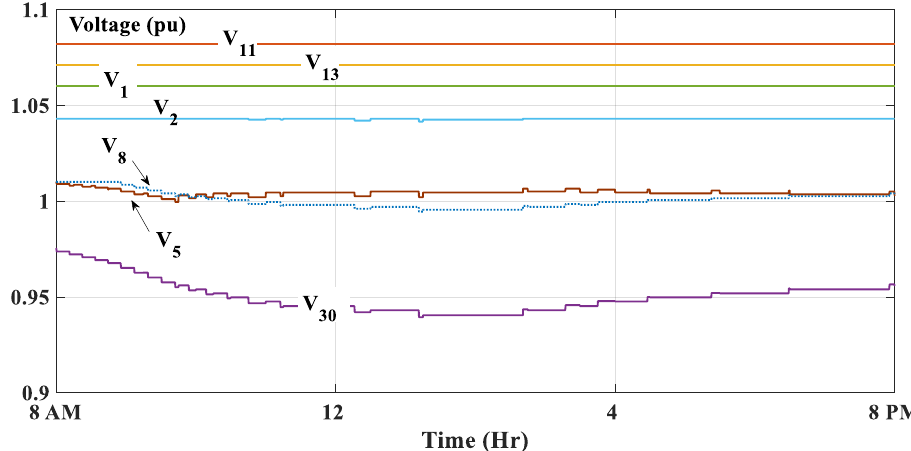
Figure 9. The voltage of the generator nodes of the IEEE 30-node and the voltage at node “30” which is a potential candidate to install a non-dispatchable wind farm.